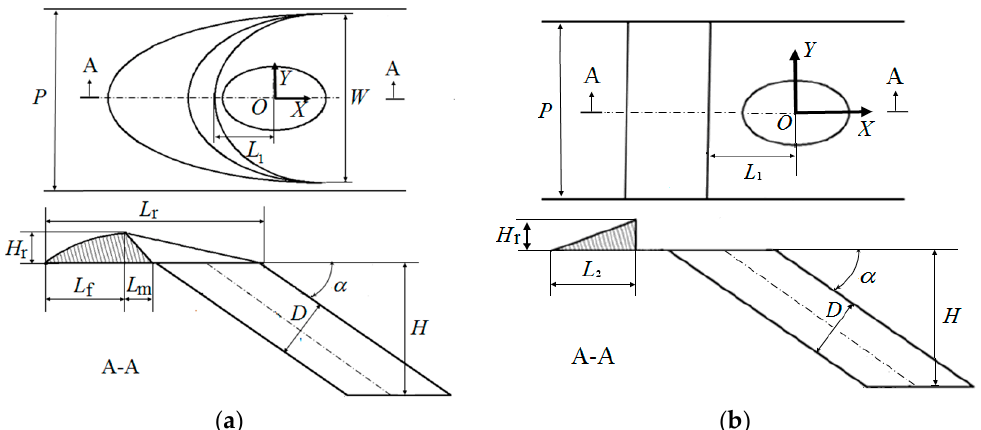
Figure 1. Schematic of computational domain.